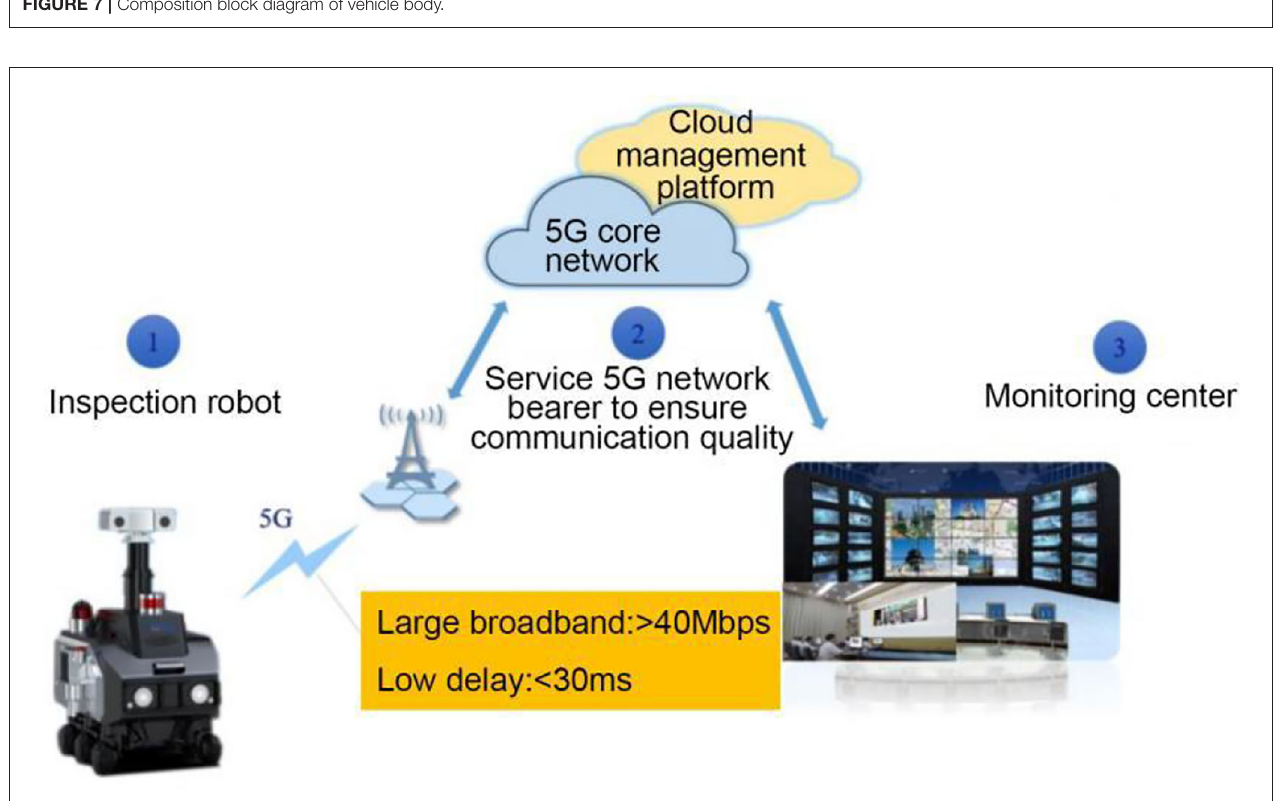
FIGURE 8 | Composition of inspection robot